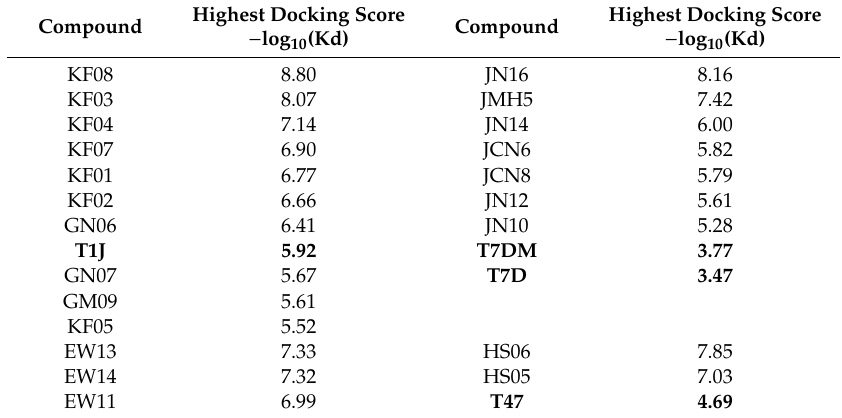
Figure 13. Structures of T7D and T1J compound derivatives designed for hydrogen bonding dataset. Table 7. Docking scores for T47, T1J, and T7D derivatives having hydrogen acceptors and donor